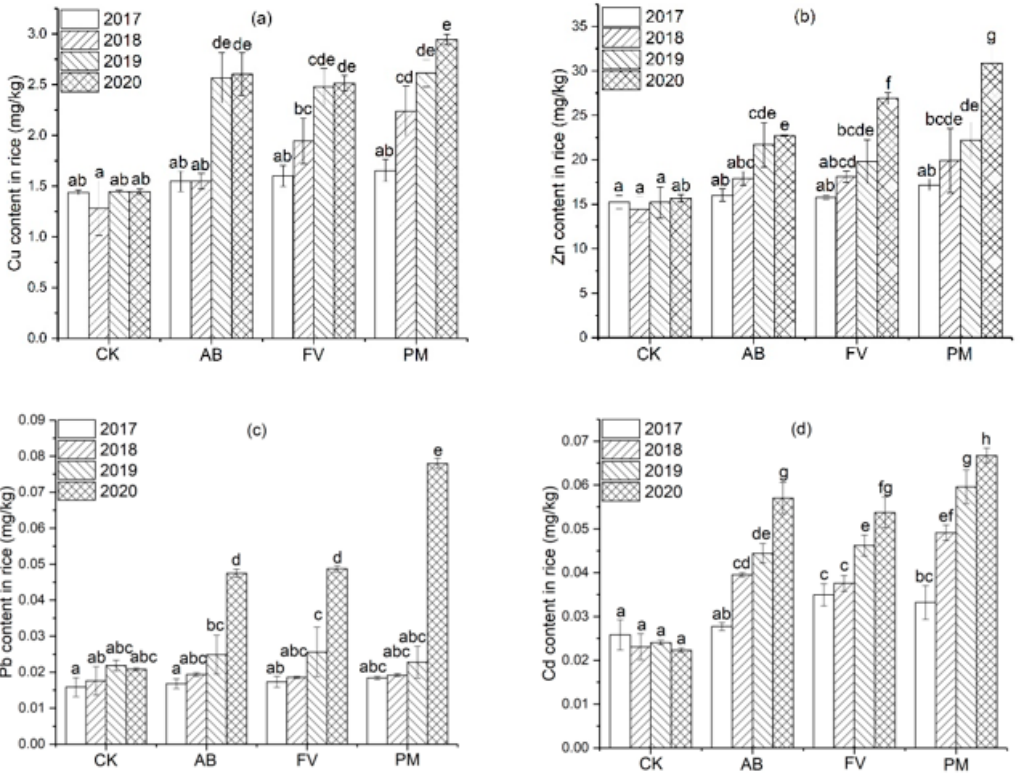
Figure 8. ( a ) Cu content in the brown rice by the different fertilizer treatments during the four experimental years; ( b ) Zn content in the brown rice by the different fertilizer treatments during the four experimental years; ( c ) Pb content in the brown rice by the different fertilizer treatments during the four experimental years; ( d ) Cd content in the brown rice by the different fertilizer treatments during the four experimental years. Data are expressed as means ± SD; n = 3. Different letters on data in the same group indicate a significant difference between them at p < 0.05 level.